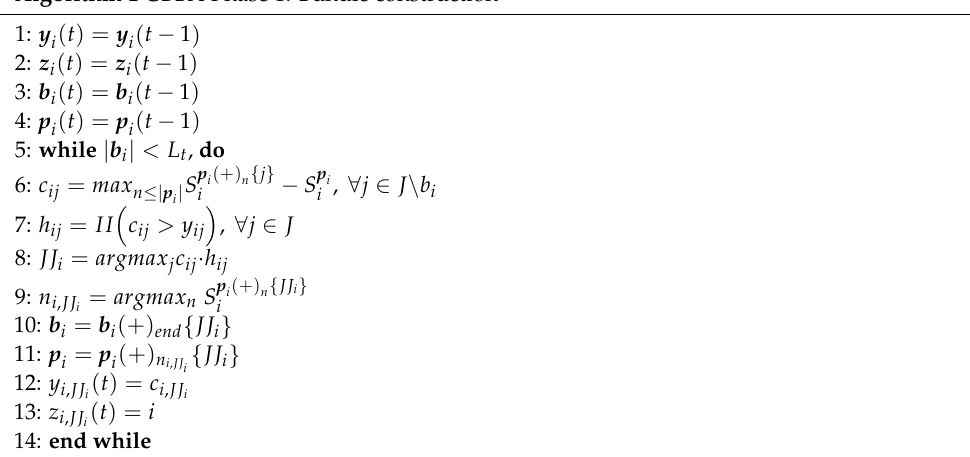
Algorithm 1 CBBA Phase 1: Bundle